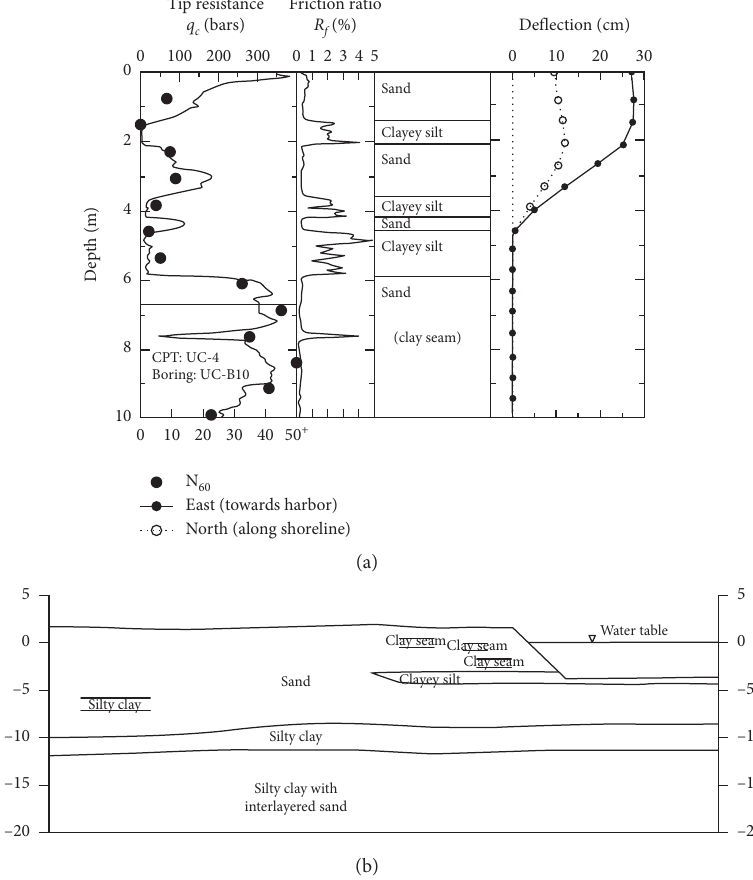
Figure 5: Soil profiles by Boulanger et al. [30]. (a) Soil profile through SI-2 inclinometer. (b) Soil profile at building No. 4 at MBARI facilities. Table 3: Soil parameters used for nonlinear effective analysis.